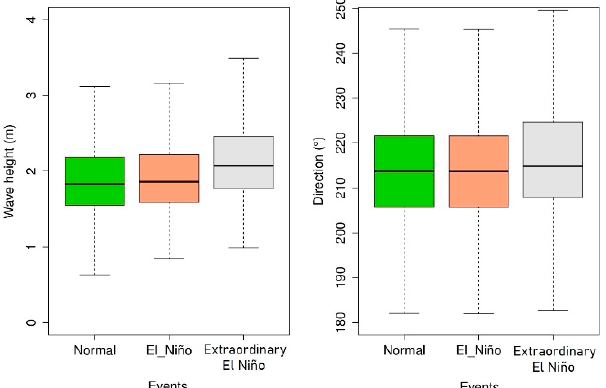
Figure 2. Comparison of wave climate conditions in normal, El Niño, and extraordinary El Niño years. Figure was created based on data presented in [13].